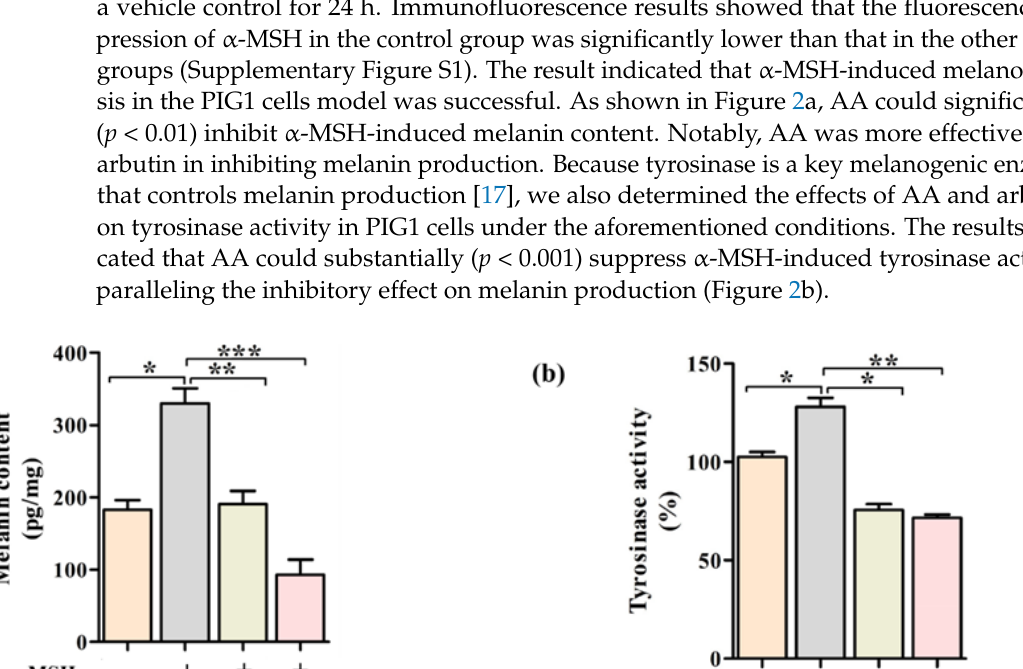
Figure 1. Chemical structure of atraric acid ( a ). The viability of different concentrations ( b ).